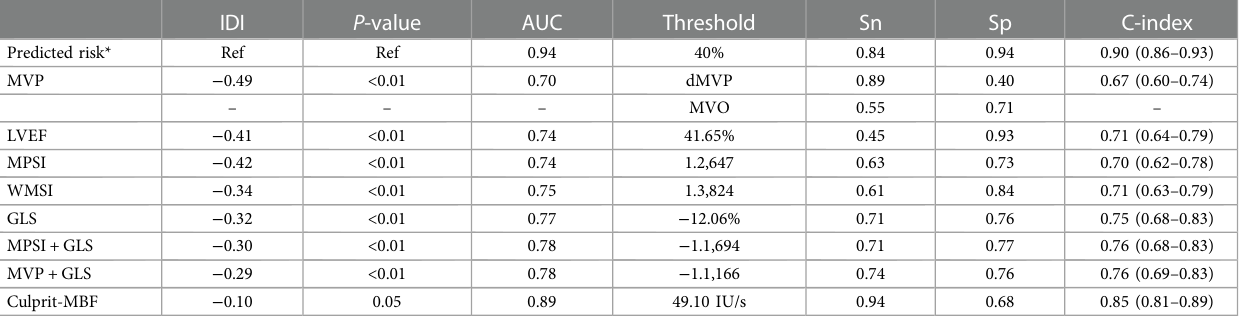
TABLE 2 Comparison of the discrimination of different models predicting MACE at 6-month.